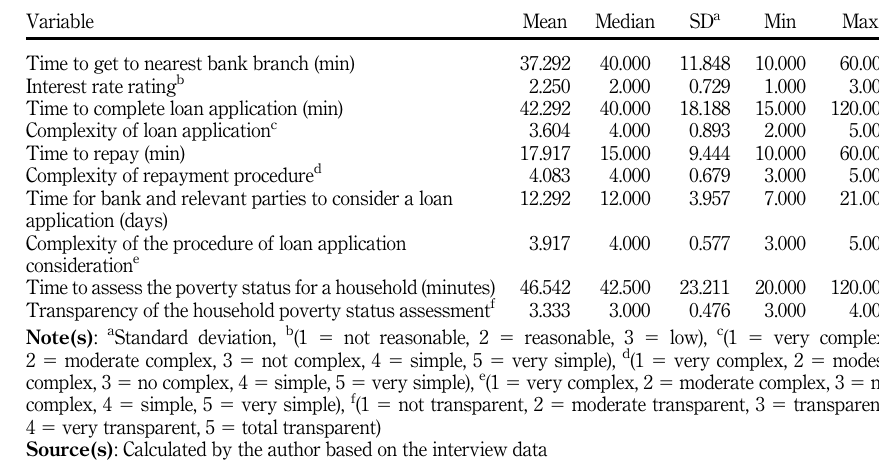
Table 5. Barriers of the access to VBSP preferential loans